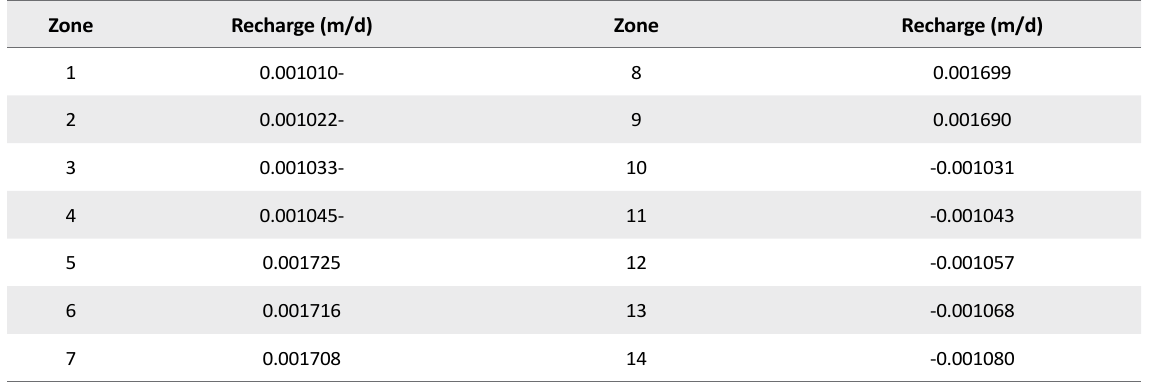
Table 2. Applied recharge values